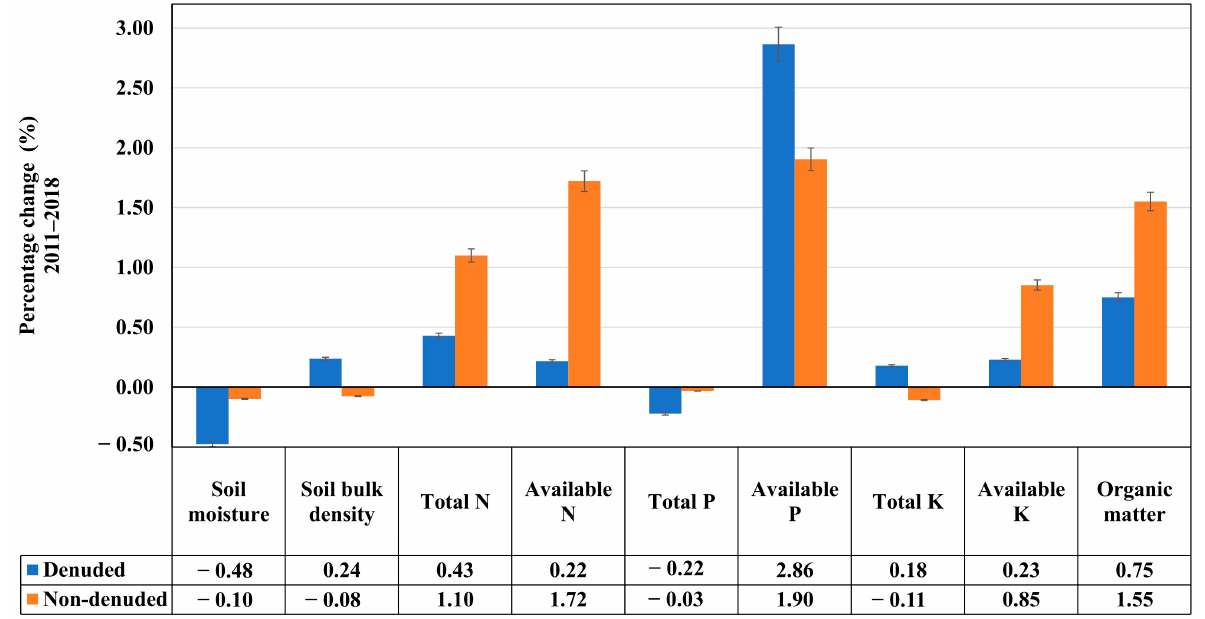
Figure 11. Comparison of soil quality between denuded area and non-denuded area.